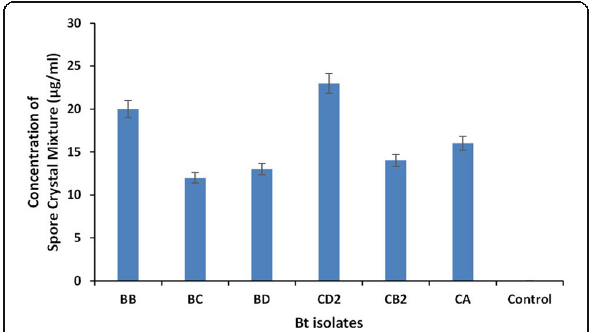
Fig. 7 LC 50 values of spore-crystal mixtures of Bacillus thuringiensis isolates against J2 juveniles of Meloidogyne incognita under in vitro